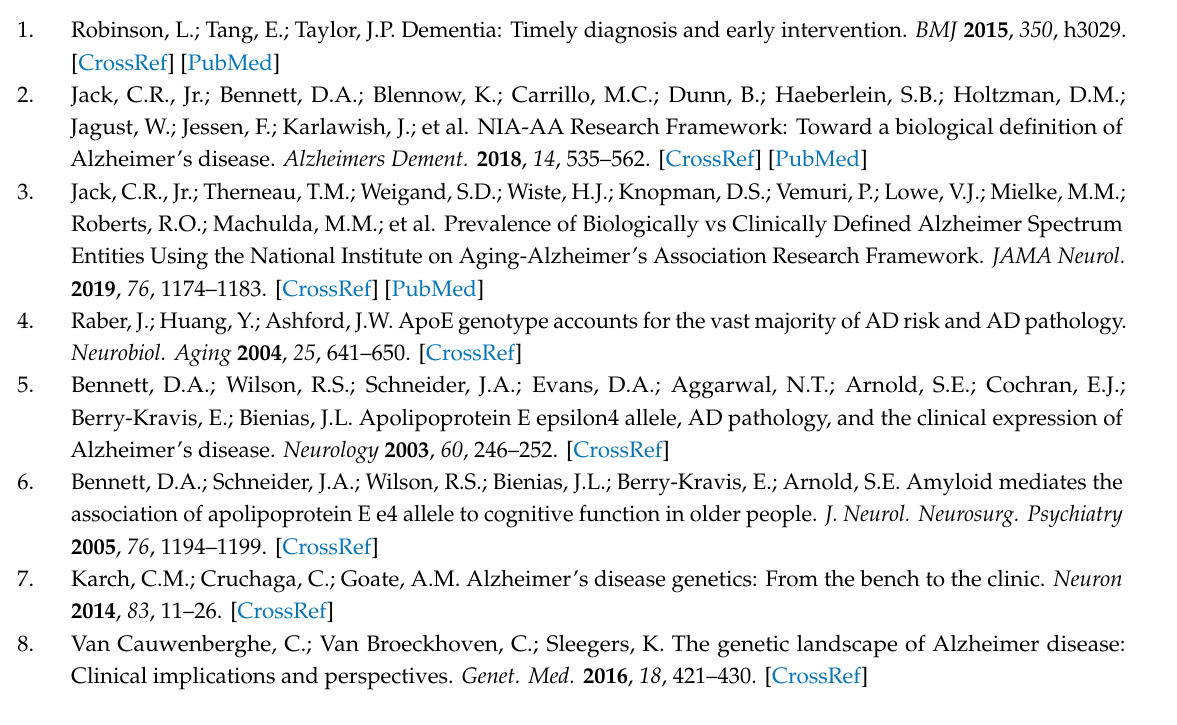
Table S1. Genes di ff erentially expressed in each arrays. Table S2. Shared genes between the MCI arrays and the ADD arrays. Table S3. Specific and shared genes from the MCI and ADD meta-analysis. Table S4. Genes in each pathway. Table S5. Associated disease. Figure S1: UpsetR analysis of the genes down and up regulated in MCI (A and B, respectively) and of the genes down and up regulated in ADD (C and D, respectively). The UpSetR diagram was created using https: // gehlenborglab.shinyapps.io / upsetr / . Author Contributions: V.B. and J.A.P. conceived and designed the study, analyzed the data, wrote the paper, and contributed to the designs of the methods that were used in this study. All authors have read and approved the final version of the